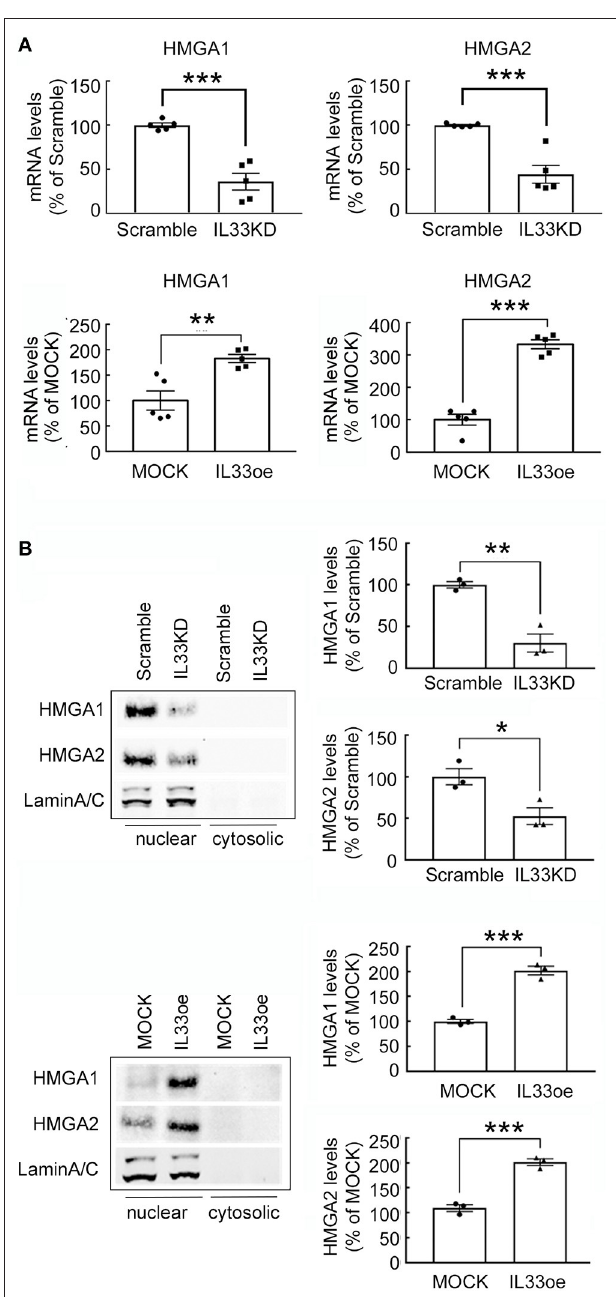
FIGURE 8 | Expression of non-histone proteins HMGA1 and HMGA2 is mediated by IL-33 in U251MG cells. (A) HMGA1 and HMGA2 mRNA expression in Scramble-, IL33KD-, MOCK, and IL33oe-U251MG cells was examined by qPCR analysis. The results are presented as mean ± SEM from five cell passages ( n = 5). ** P < 0.01, *** P < 0.001 vs. Scramble or MOCK. (B) Nuclear proteins and cytosolic proteins were isolated from Scramble- and IL33KD-U251MG cells, as well as MOCK- and IL33oe-U251MG cells. Representative images of the Western Blot analysis show the nuclear levels of HMGA1, HMGA2, and Lamin A/C in the transfectants. The nuclear levels of HMGA1 and HMGA2 proteins were normalized by the level of Lamin A/C (as a loading control). The results are presented as mean ± SEM from the three cell passages ( n = 3). * P < 0.05, ** P < 0.01, *** P < 0.001 vs. Scramble or MOCK. IL-33, interleukin-33; IL33oe, IL-33 overexpression; HMGA1, the high mobility group A1; HMGA2, the high mobility group A2; qPCR, quantitative